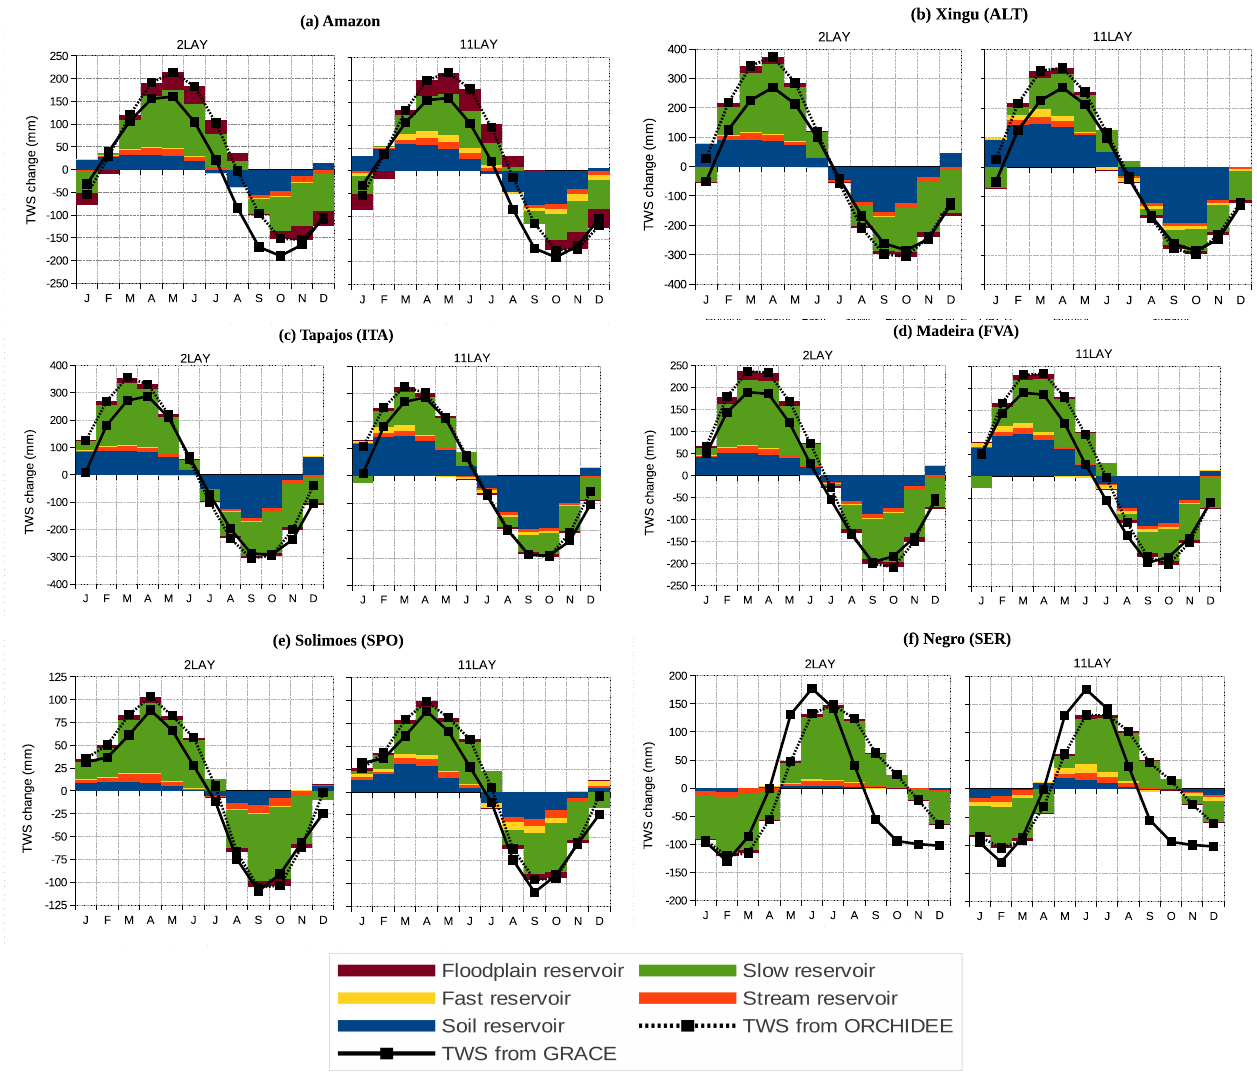
Figure 3. Monthly mean change of the water storage components (mm) in the different water reservoirs of ORCHIDEE for simulations with the 2LAY (left) and the 11LAY (right), for the Amazon Basin and its sub-basins, averaged over the period 2003–2008. The thick black line represents the independent GRACE observation. The dotted black line is the sum of water storage across all the ORCHIDEE water reservoirs.